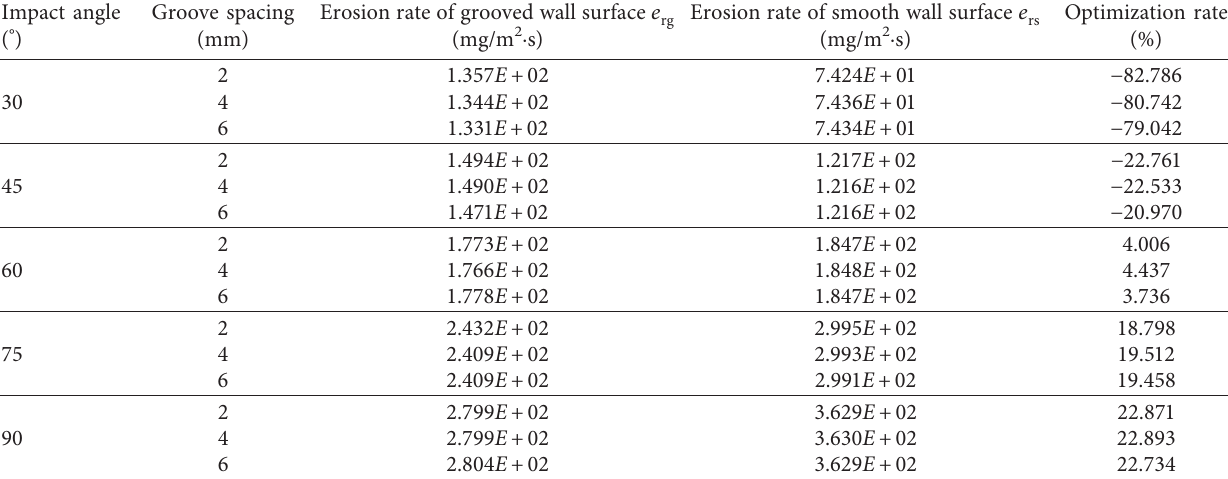
Table 4: Erosion rates of grooved and smooth wall surfaces under different groove spacings and impact